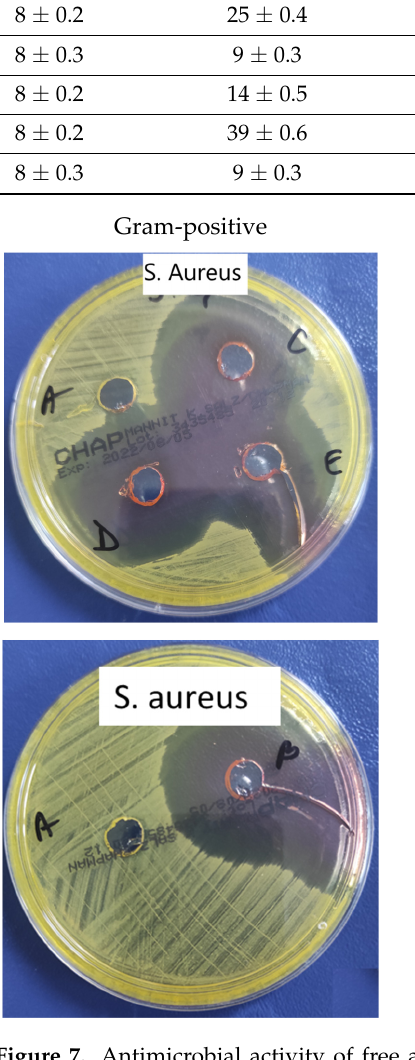
Figure 7. Antimicrobial activity of free and API-loaded PMs against Gram-positive and Gram- negative strains. A-negative control (free F127 micelles), B-positive control (API), C—F127/API = 2/1, D—F127/API = 5/1 and E—F127/API = 10/1.